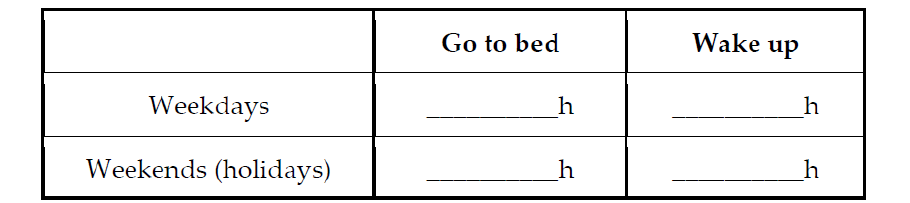
Figure 1. Question format asking the wake-up and go-to-bed times on weekdays and weekends.